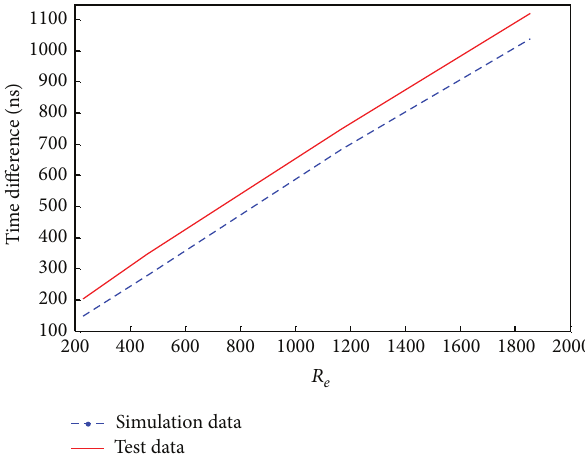
Figure 13: The relationship curve of time difference and 𝑅 𝑒